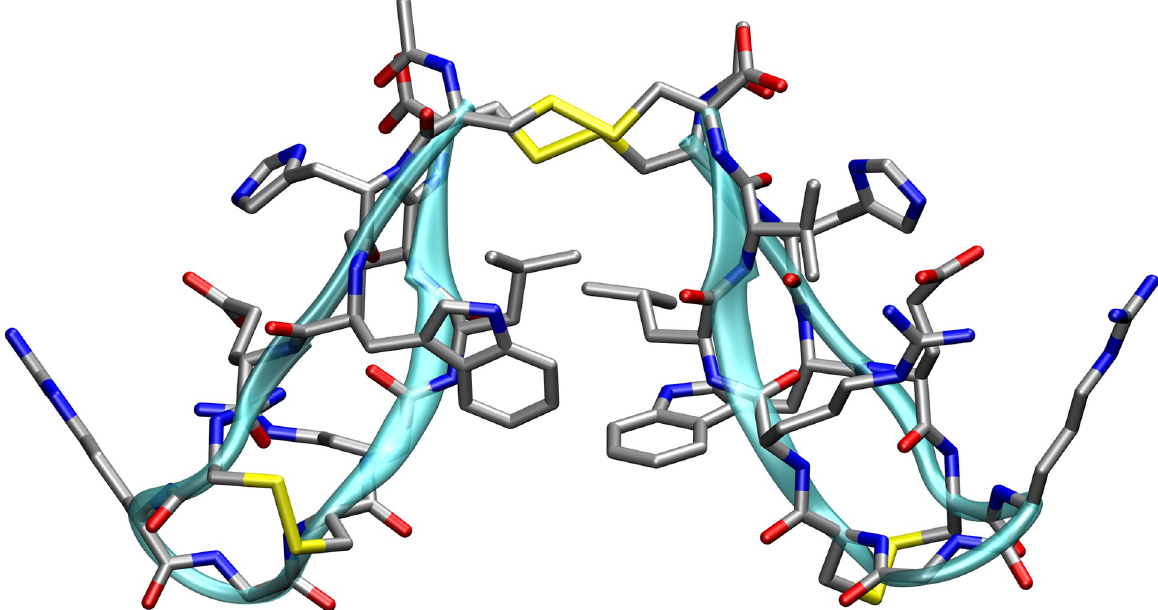
Fig 1. Starting structure of the dimeric hinge peptide. Lowest energy conformer of the dimeric hinge peptide (CHWECRGCRLVC) 2 obtained after a simulated annealing protocol using an NMR-derived nuclear Overhauser effect and dihedral restraints. The hydrogen atoms are omitted for better